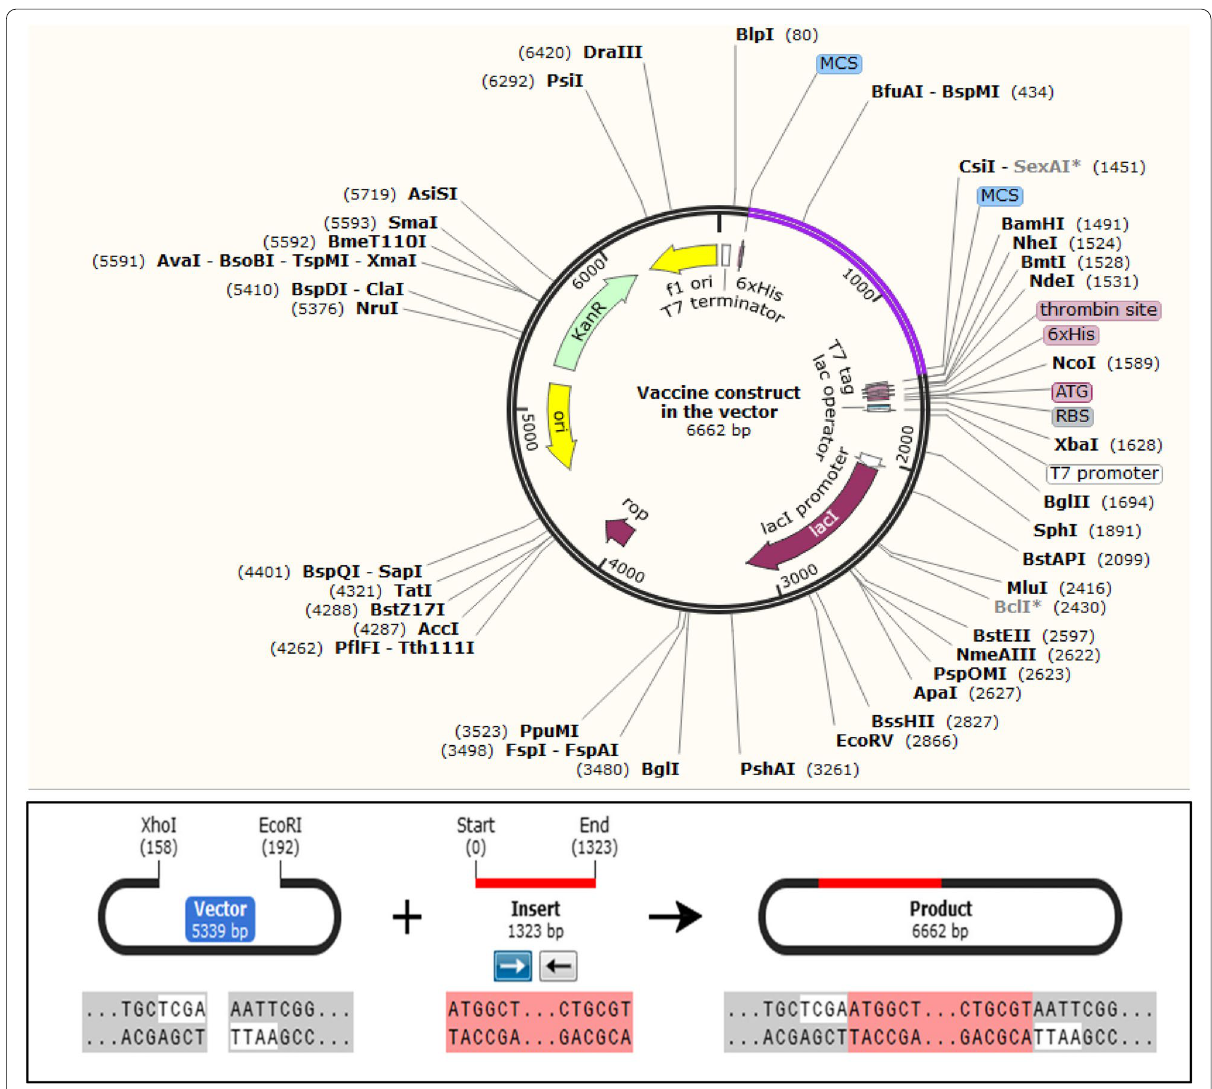
Fig. 8 In silico cloning of the designed vaccine construct in the pET28a (